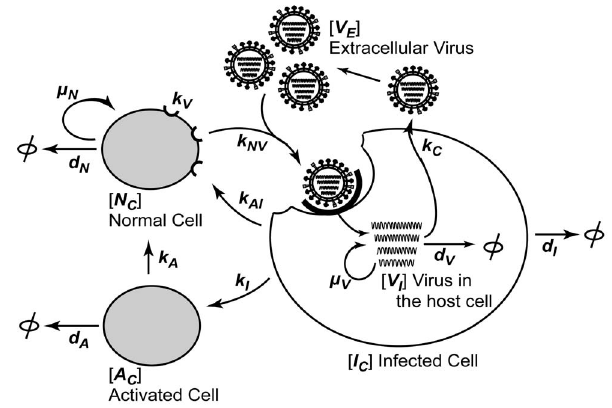
Figure 1. A schematic diagram of the model system. Based on the interaction between the influenza virus and the host cells, three states of host cells ( N C , I C , and A C ) and two types of viruses ( V E and V I ) were expressed with 13 parameters. For details, see Methods and Table 1.